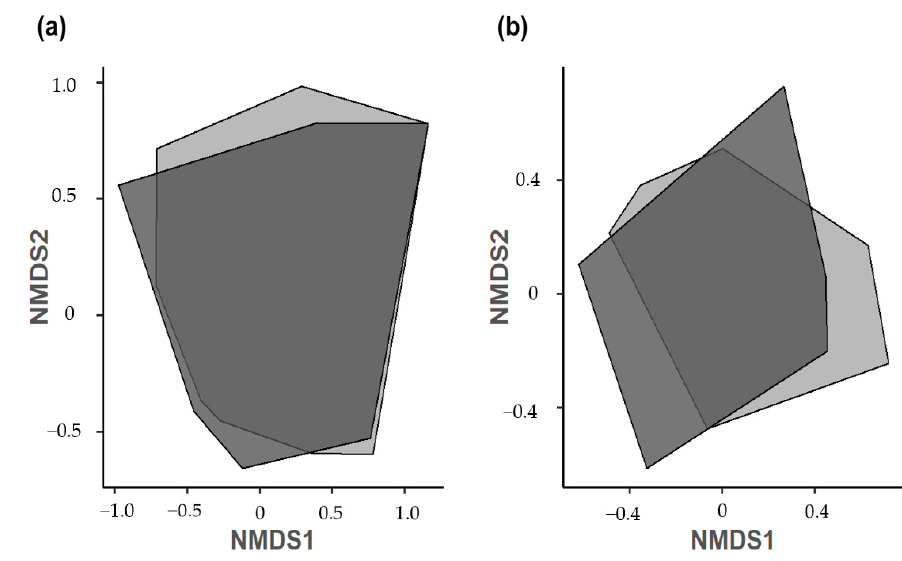
Figure 4. Shows the ordination of ( a ) insect and ( b ) spider communities (non-metric multidimensional scaling) separated by control (light grey convex hulls) and exclosure plots (dark grey convex hulls). Insect and spider communities did not differ between treatments.